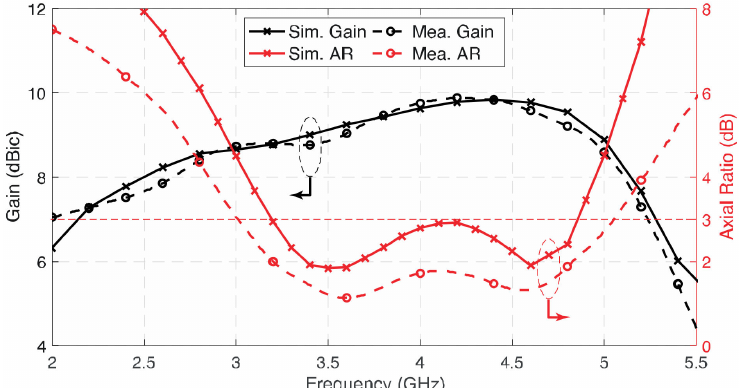
Figure 12. Simulated and measured gain and axial ratio of the proposed